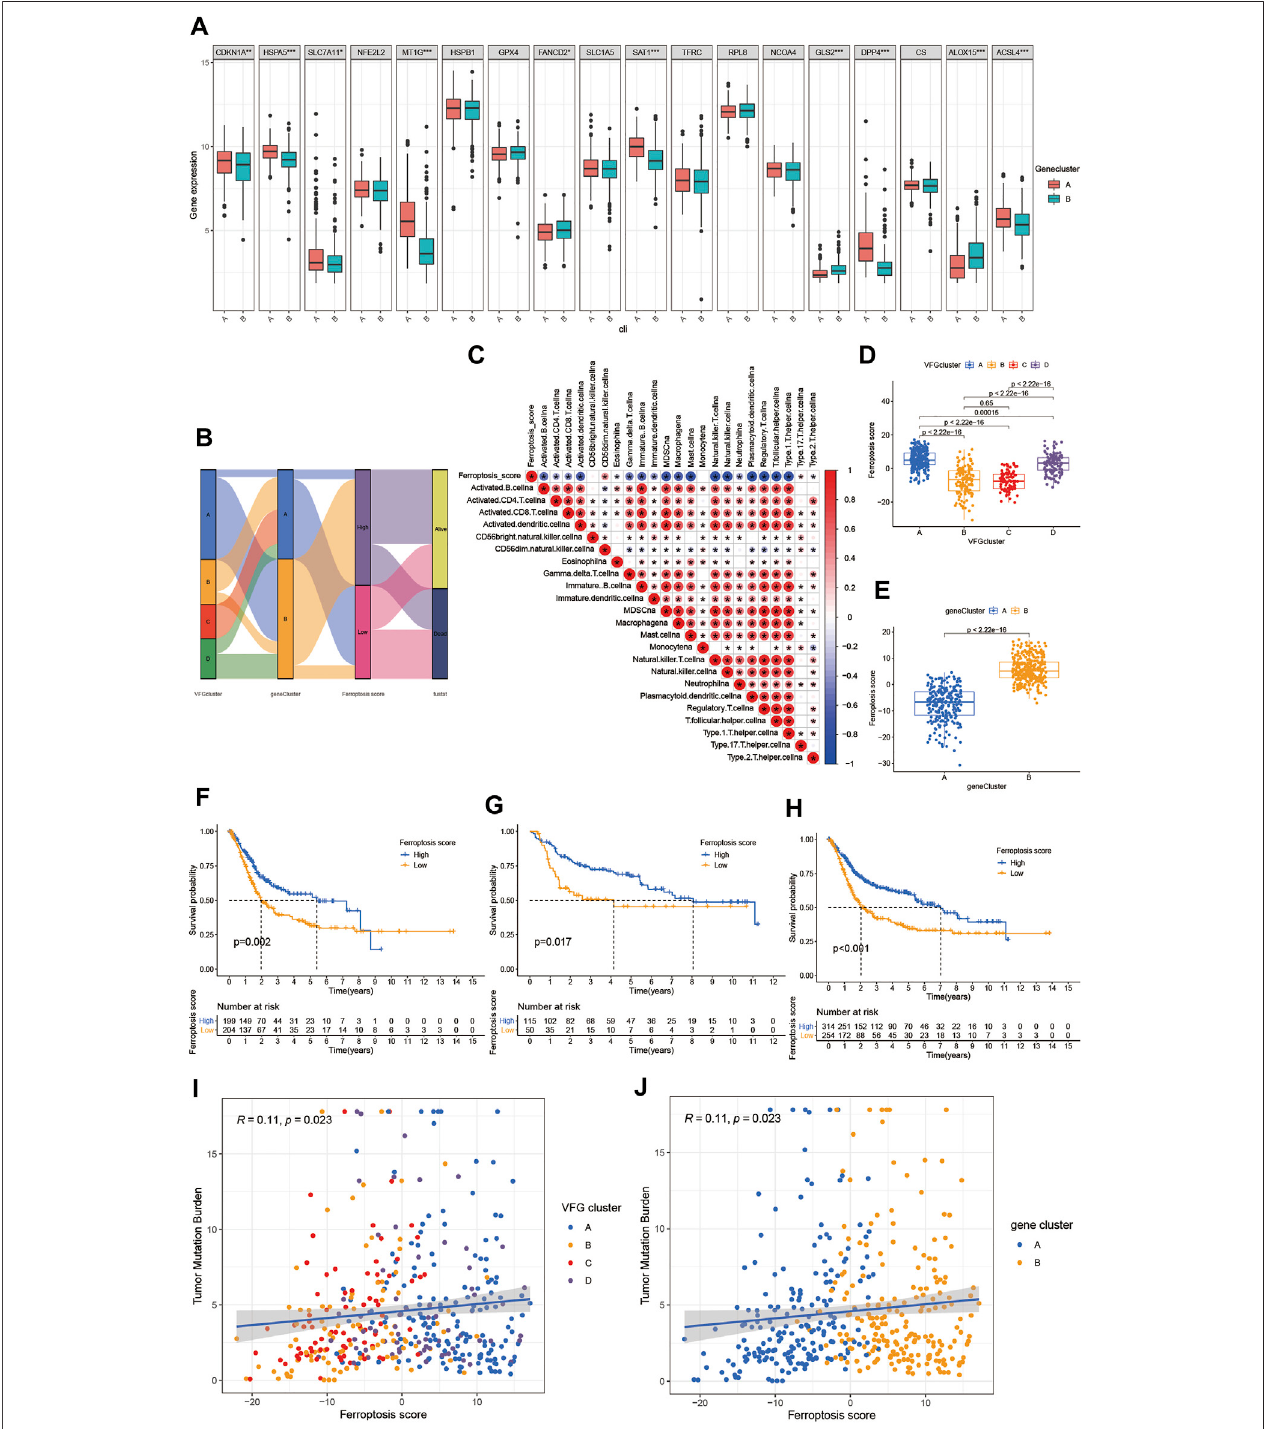
FIGURE5| Establishmentoftheferroptosisscoreanditsinteractionwithtumorclinicopathologicalcharacteristics. (A) Expressionof18FRGsintwogeneclusters. The upper and lower ends of the boxes represented interquartile range of values. The lines in the boxes represented median value, and black dots showed outliers. The asterisks represented the statistical p value (* p < 0.05; ** p < 0.01; *** p < 0.001). The student ’ s t test was used to test the statistical differences between two gene clusters. (B) Sankey diagram showing the changes of VFGclusters, survival status, gene cluster, and ferroptosis score. (C) Correlations between the ferroptosis scoreandtheknownimmunecellsinmeta-cohortusingSpearman analysis.Negativecorrelationwasmarkedwithblueandpositivecorrelationwithred. (D) Differences in the ferroptosis score among four VFGclusters in meta-cohort. The Kruskal Wallis H test was used to compare the statistical difference between four VFGclusters ( p <